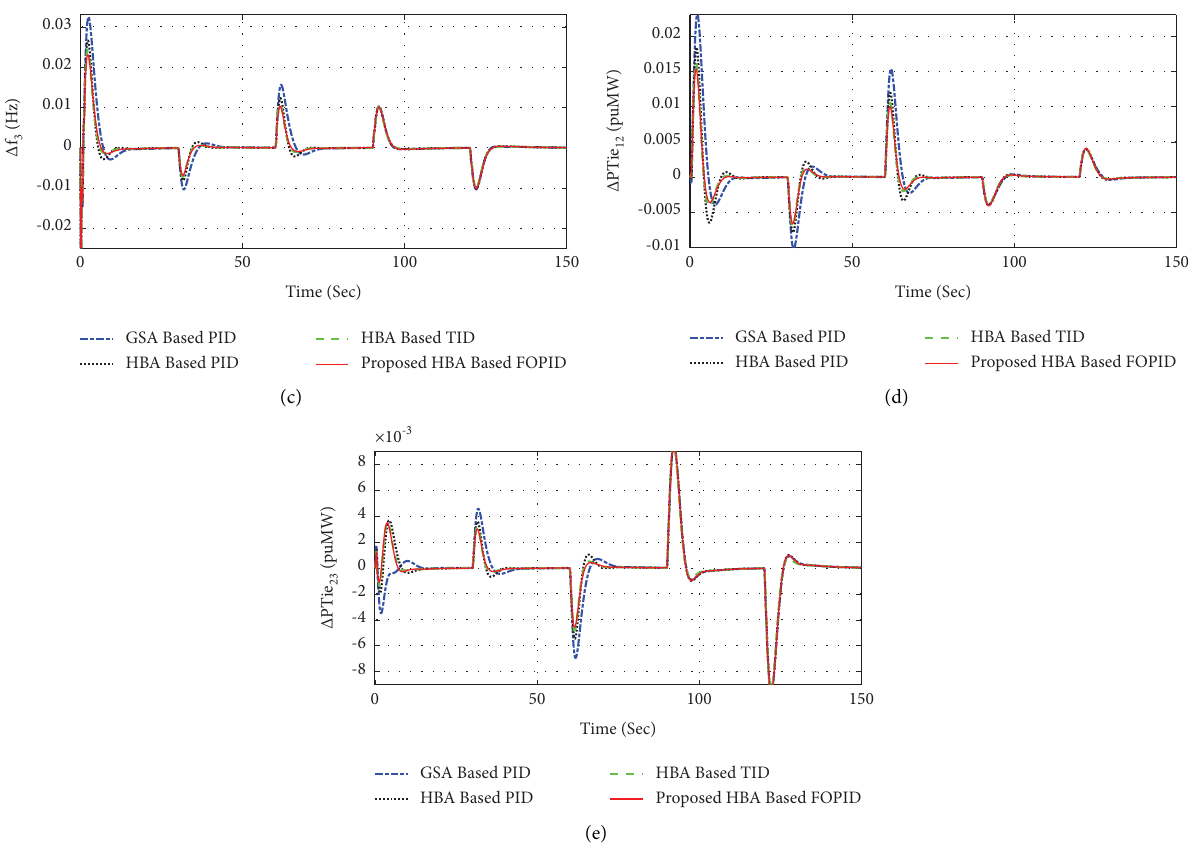
1 , (b) A 2 , (c) A 3 , (d) P tie12 , and (e) P tie23 .